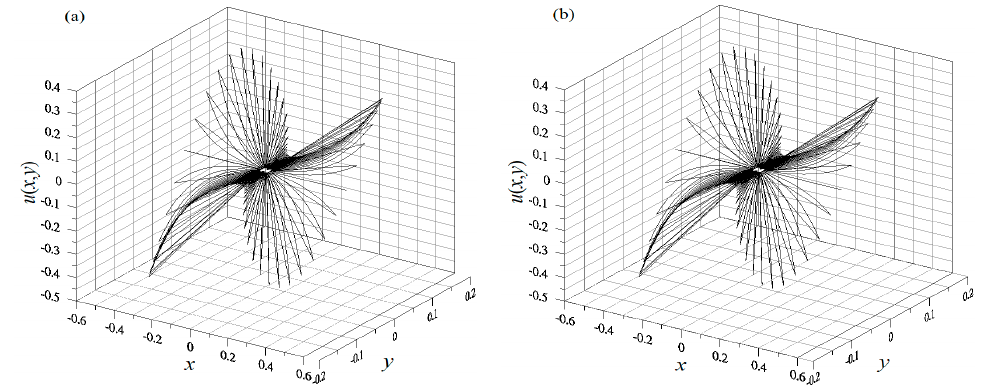
Figure 2. The exact solutions for the steady-state AC equation with peanut-shaped domain are shown in ( a ), and in ( b ) the proposed approach solution without random noise.